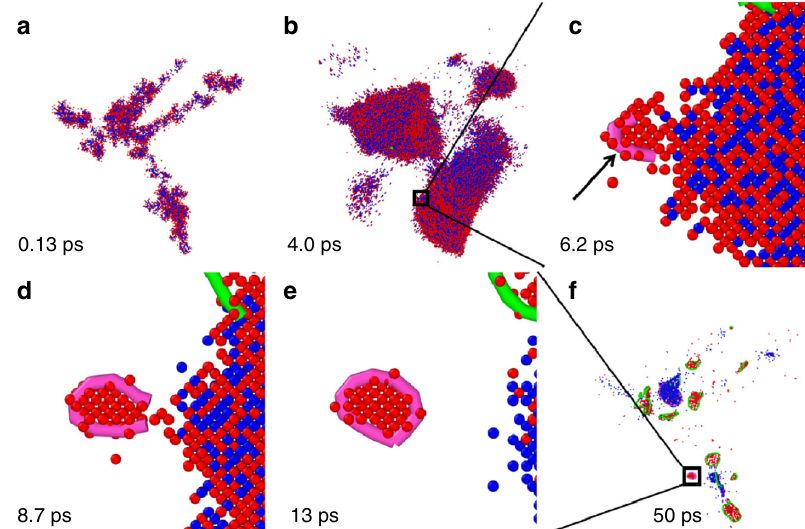
Fig. 1 Punch-out procedure. A primary knocked-on atom with the kinetic energy of 200 keV at time zero moves along the <351> direction to initiate the cascade, with sequence of a subcascade, b thermal spike, c <100> interstitial dislocation loop nucleation, d formation, and e stabilization in the zoom-in region, and f the quenched stage. The snapshots are taken as side-views along the <010> direction of the cubic system, for better view of the <100> dislocation loops. Only the defects are displayed. The red particles stand for interstitial atoms and the blue particles are for vacancies. The black arrow is the eye-guide for the position of the nucleation of the <100> interstitial-type dislocation loops. The pink lines denote <100> dislocation loops and the green lines are for the <111> dislocation